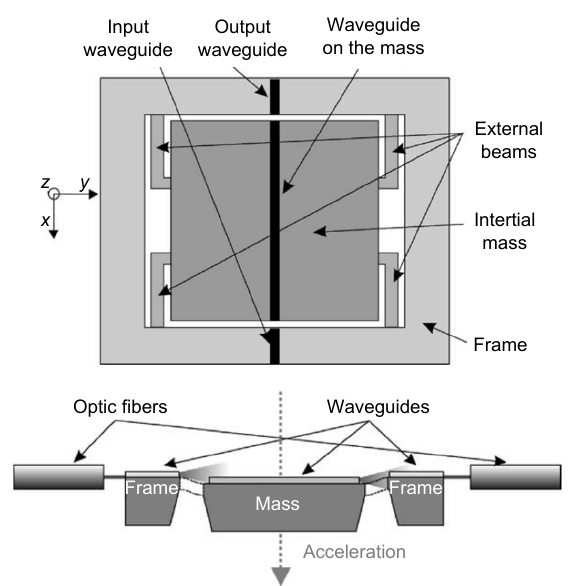
Fig. 4 | Simplified model of a MOEMS accelerometer based on light intensity. Figure reproduced with permission from ref. 17 , IEEE.